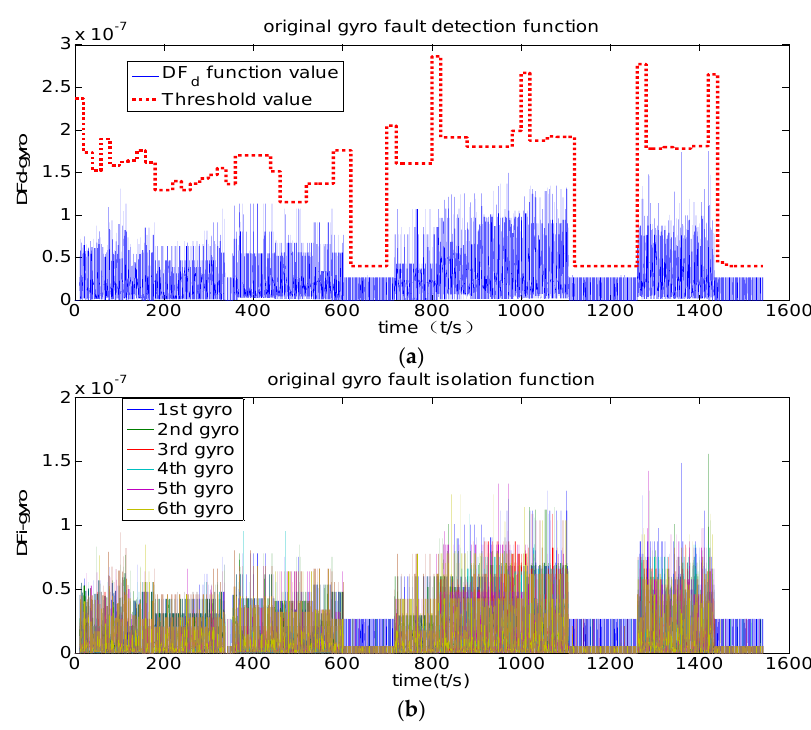
Figure 14. Original channel filter. ( a ) Fault detection; ( b ) Fault isolation.